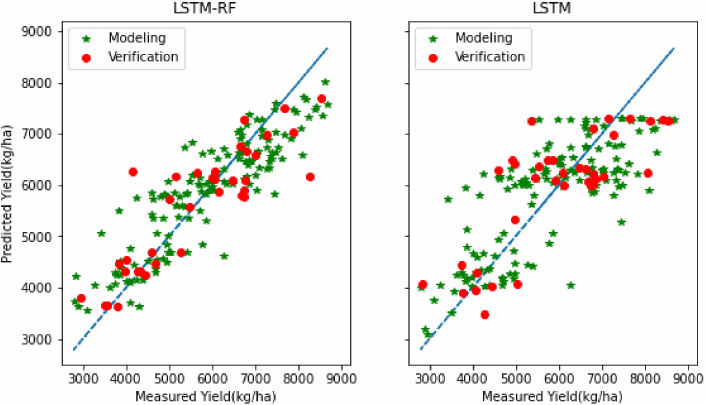
Figure 10. The relationships between the measured and predicted values of wheat yield based on the LSTM and LSTM-RF